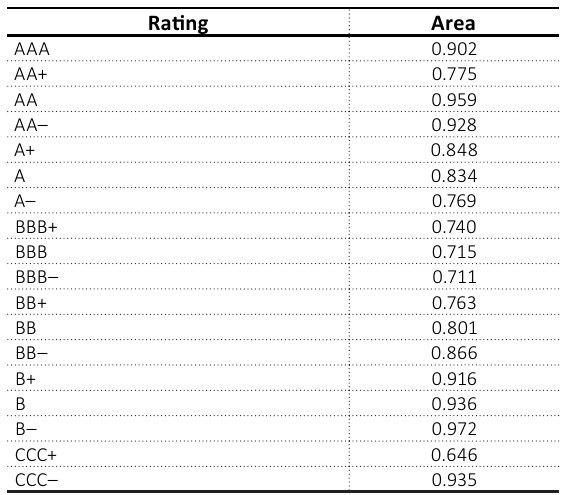
Table 7. Areas under the ROC curves for the S&P ratings prediction (sample I)